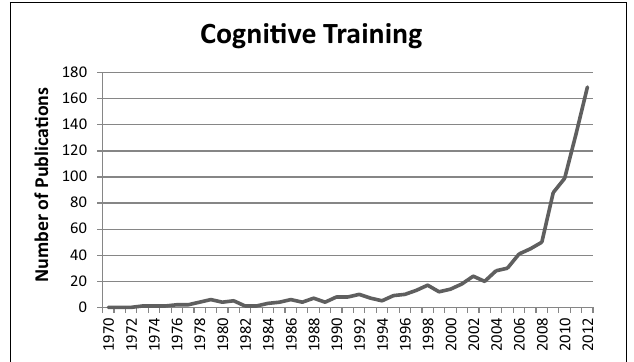
FIGURE 1 | Number of publications per year in the field of synaesthesia research. The figure represents the hits for the search terms “synaesthesia OR synaesthesia” in the title, abstract, or keywords. Source: Scopus (17/09/2013).